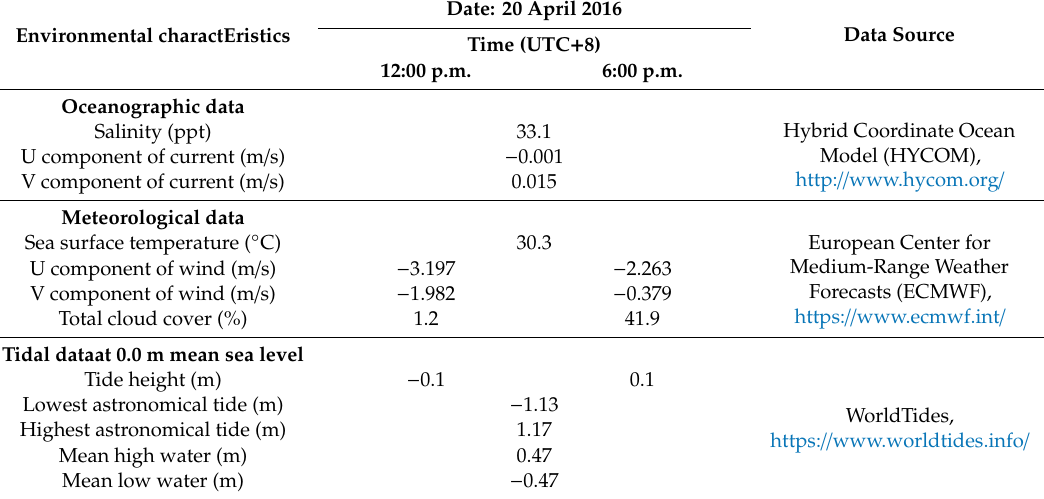
Table 2. Oceanographic, meteorological, and tidal data during unmanned aerial vehicle (UAV) missions and in situ benthic surveys. UTC—Coordinated Universal